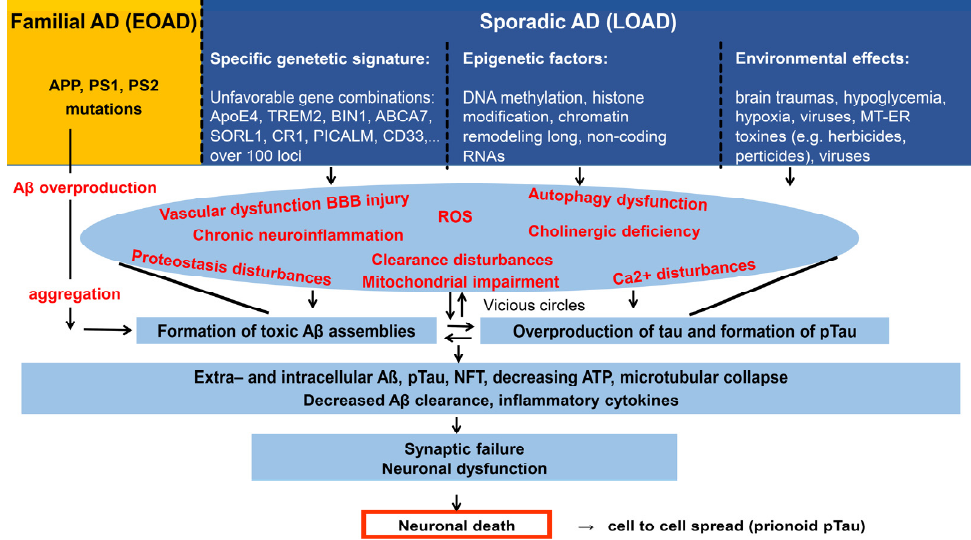
Figure 1. The funnel model of AD. It shows the interrelated destructive processes acting in vicious circles, leading to widespread cell death. In familial AD cases (left side), mutations in APP, presenilin 1 and 2 (PS1 PS2) genes induce A β overproduction and formation of toxic aggregates. In the sporadic form (LOAD), aging, unfavorable gene combinations, epigenetic changes, and various environmental factors induce slow changes in the brain. Vascular and autophagy dysfunctions, BBB injury, proteostasis, and clearance disturbances lead to A β accumulation and subsequent formation of toxic A β and tau assemblies in vicious circles. Microtubular collapse results in synaptic failure, dysfunction, and death of neurons. A β and tau act in synergy in the pathological cascades.